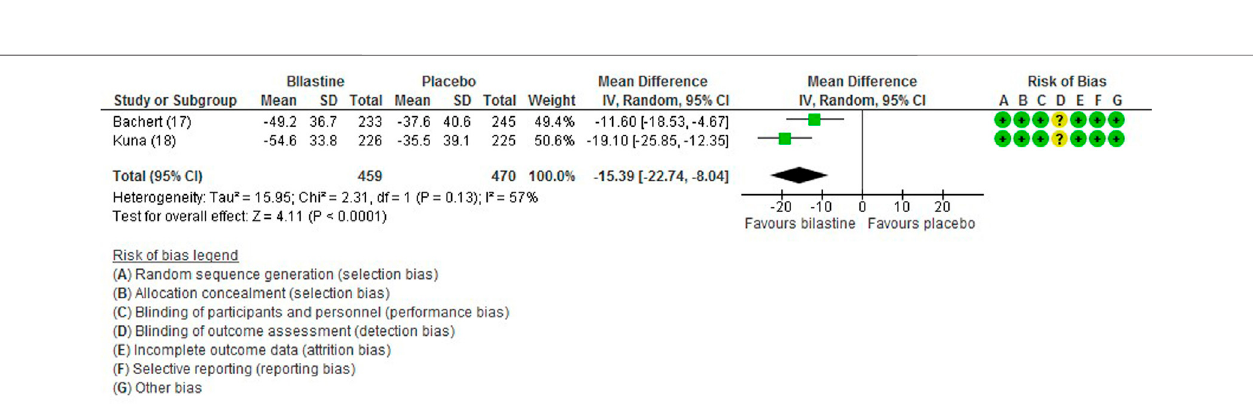
FIGURE7| Comparisonbetweenbilastineandplacebofordiscomfortduetorhinitis. SD Standarddeviation, IV inversevariance, CI Con fi denceinterval, df degrees of freedom.